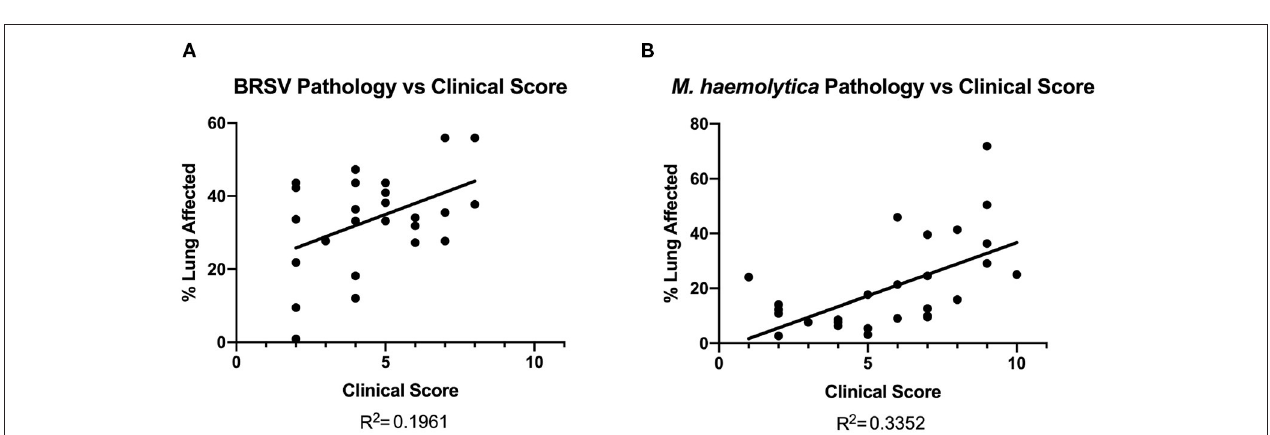
FIGURE 7 | Gross lung pathology on necropsy plotted against clinical score on day of necropsy. In both BRSV-infected (A) and M. haemolytica –infected calves (B) , the lungs were divided into 11 lobes and scored based on percentage of lung affected by gross lesions. There was a weak correlation between clinical score and gross lung pathology in both